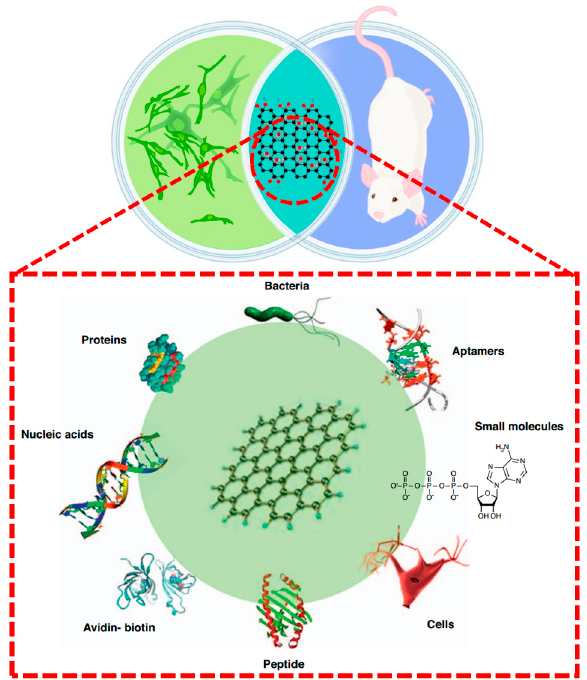
Figure 2. Although graphene oxide has been demonstrated to be cytocompatible in vitro, its compatibility in vivo in tissue sites relevant for biomedical device application is yet to be fully understood. Promising results may be achieved by proper functionalization. Graphene and its derivatives have been reported to be functionalized with avidin–biotin, peptides, nucleic acid, proteins, aptamers, small molecules, bacteria, and cells through physical adsorption or chemical conjugation. Reproduced from [37,42].